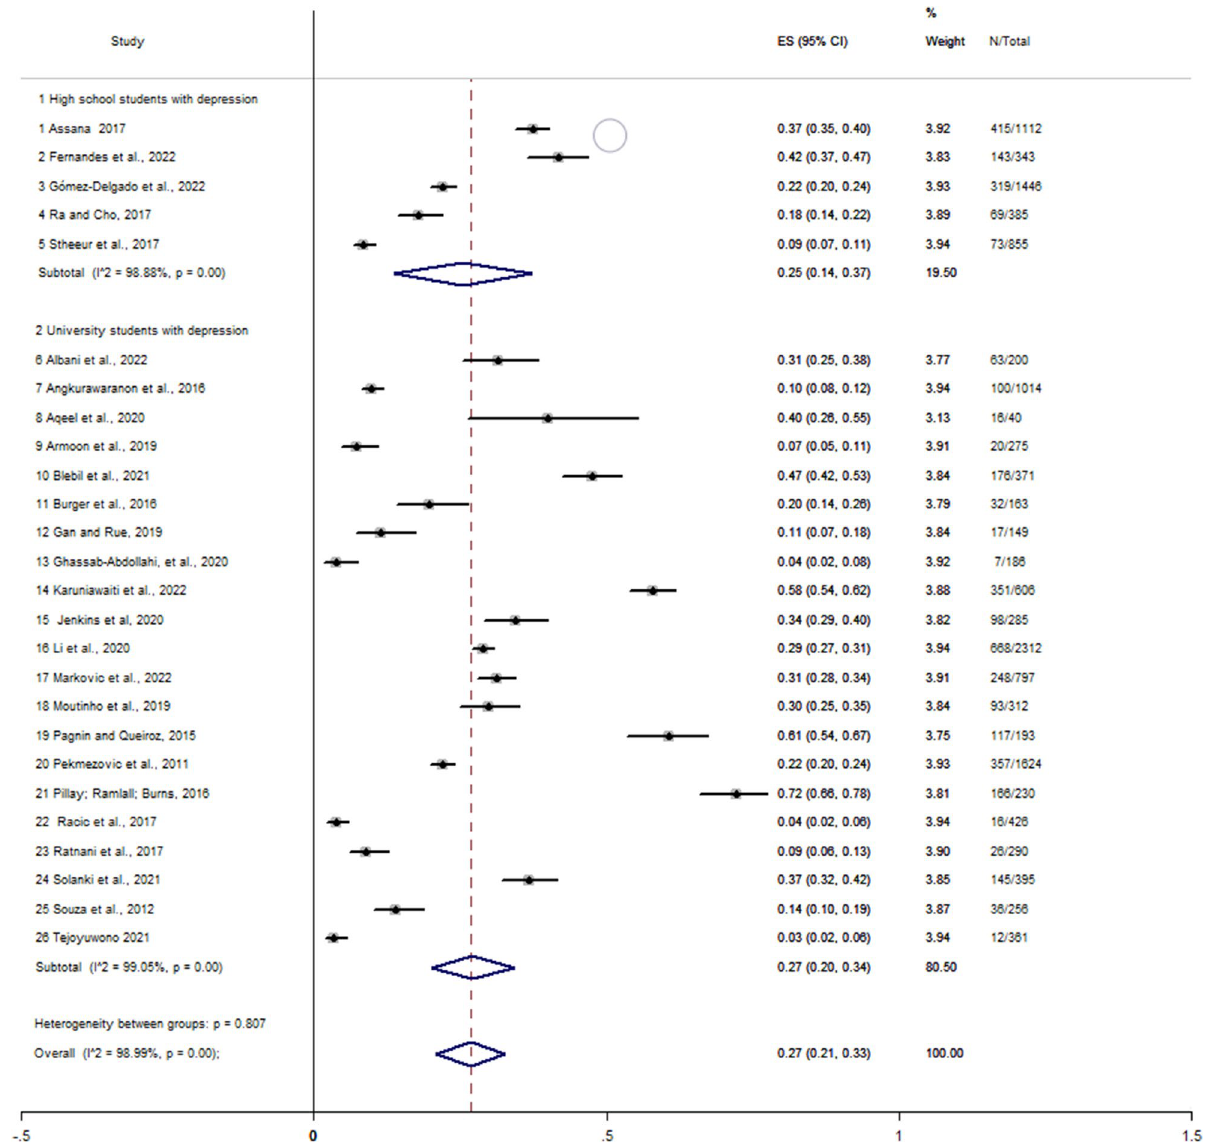
Figure 2. Forest plot evaluating the prevalence of depression in students, using data from 26 studies. Flowchart: Elaborated by the